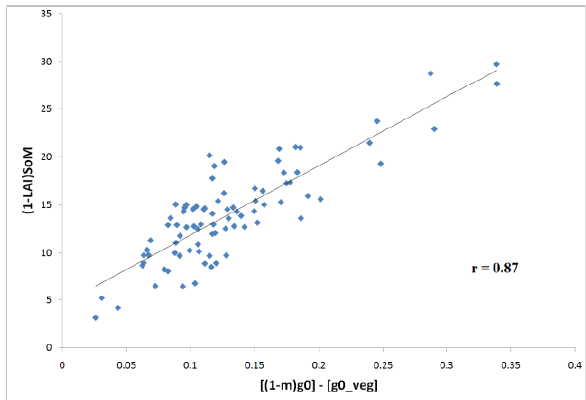
Figure 5. The scatter plot of differences in observed un- polarized component and modeled vegetation return signal with product of soil exposure and underneath soil moisture